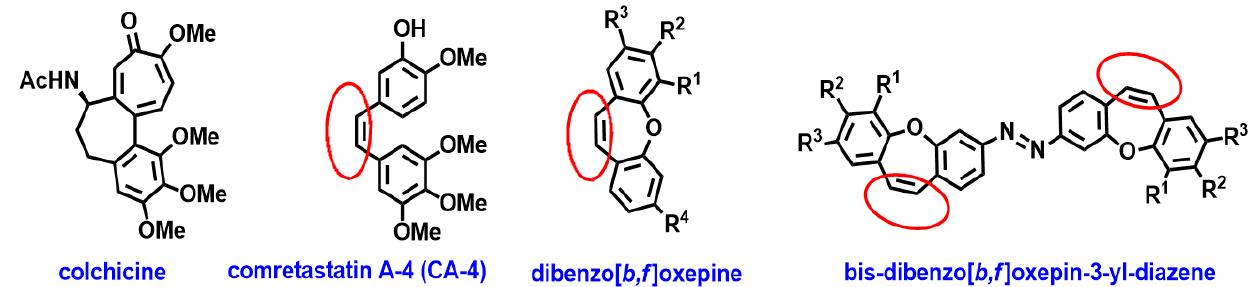
Figure 1. Structure of colchicine, combretastatin A-4, dibenzo[ b , f ]oxepine and 1,2-bis(dibenzo[ b , f ]oxepin-3-yl)diazene.